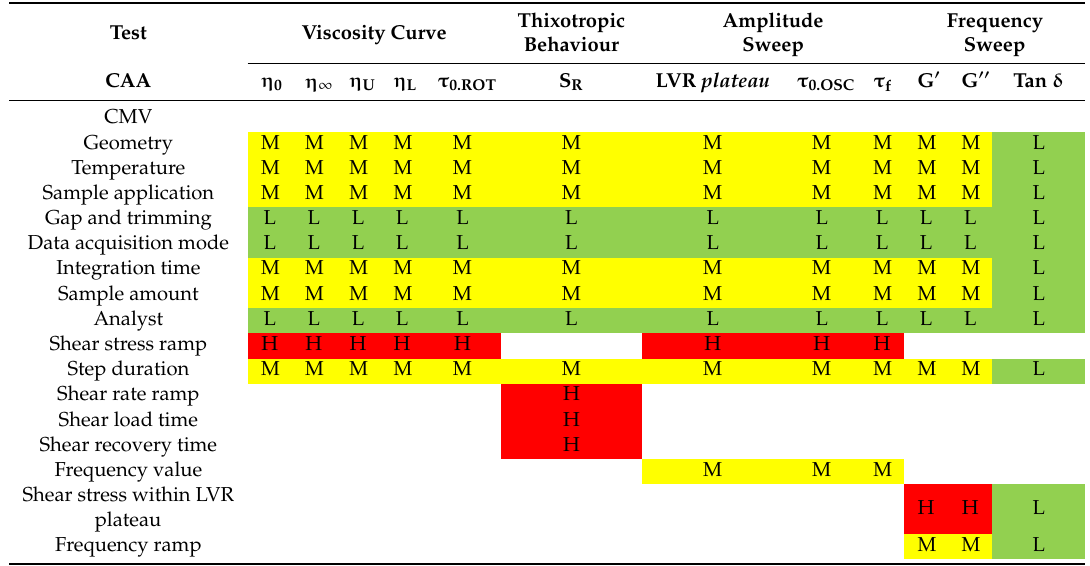
Table 1. Initial risk estimation matrix (REM) for rheology method